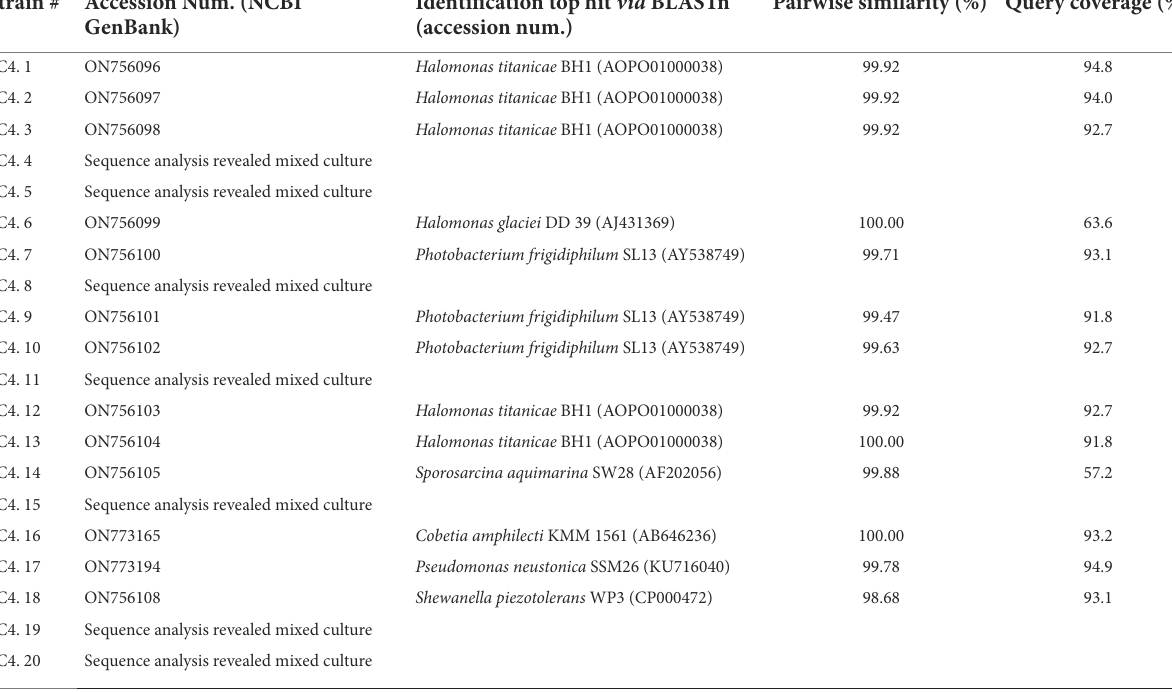
TABLE 2 Twenty individual bacterial strains were isolate from the marine sediment sample where microbial propane production was identified (FC.4). Strain # Accession Num. (NCBI Identification top hit via BLASTn GenBank) (accession